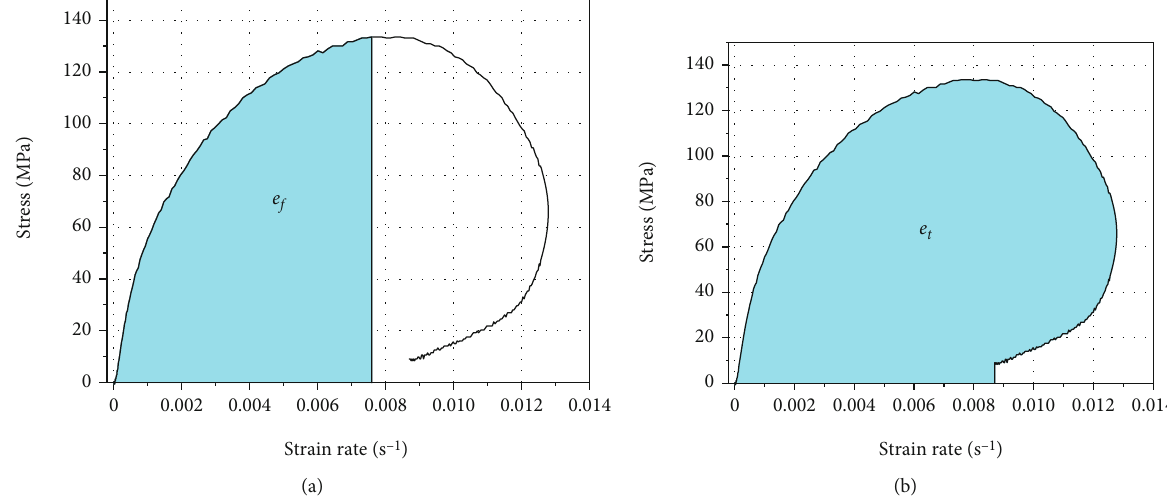
Figure 11: Calculation of energy absorption per unit volume: (a) absorption energy before peak stress and (b) total absorption